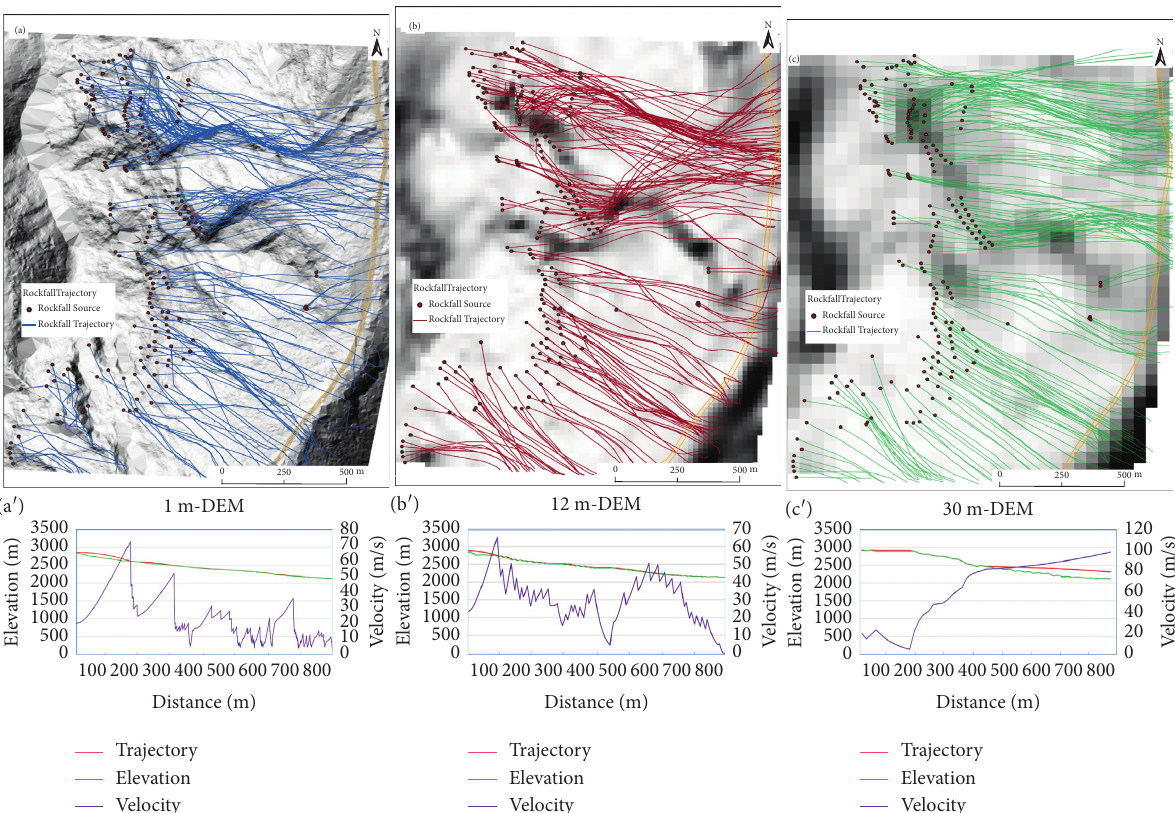
Figure 7: (a) DEM with a 1 m resolution was used to simulate the path of falling rocks, (b) using DEM with 12.5m resolution, and (c) using DEM with 30m resolution. (a ′ ) The falling speed and distance of falling rocks at a 1 m resolution, (b ′ ) the falling speed and distance of falling rocks with a 12.5m resolution, and (c ′ ) the falling speed and distance of falling rocks at a resolution of